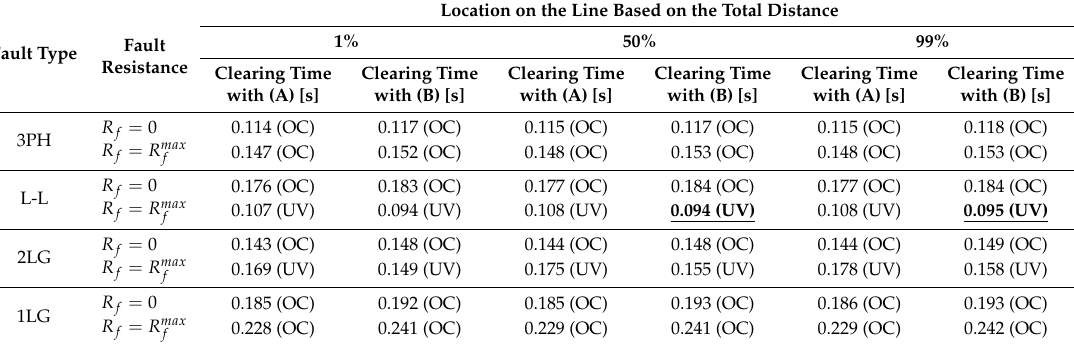
Table 4. Obtained results of RMS simulations in Line L9-10 with settings of Table 3 at 2 p.m. operating